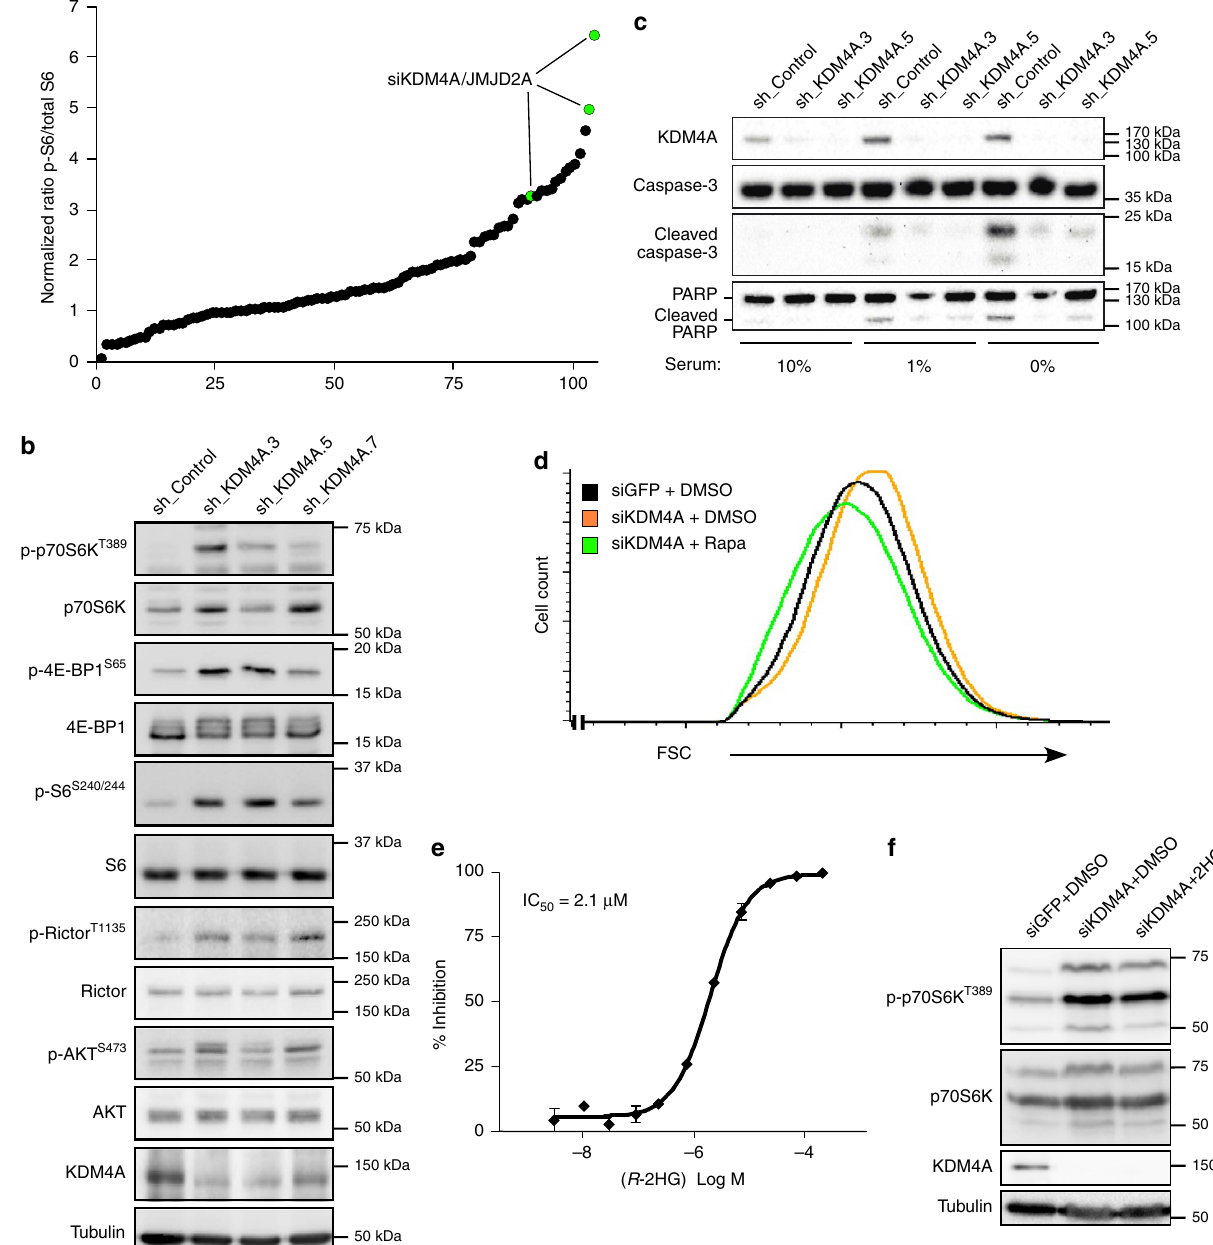
Figure 2 | Targeted-siRNA screen reveals KDM4A as an a -KG-dependent enzyme modulating mTOR activity. ( a ) siRNA screen of a KG-dependent enzymes for the involvement in mTOR signalling in HeLa cells. The experiments were performed in triplicate and the results of all experiments were plotted. The levels of phosphorylated S6 on serines 240/244 were normalized to total S6 protein. ( b ) KDM4A knockdown increases mTORC1/2 signalling. Depletion of KDM4A by lentiviral infection in HeLa cells using three different shRNAs. Whole-cell lysates were blotted for mTORC1/2 activation. ( c ) Depletion of KDM4A protects against apoptosis induced by serum deprivation. HeLa cells expressing a control shRNA or shRNAs targeting KDM4A were grown in media containing the indicated concentrations of serum for 24h. Cell lysates were then analysed by western blotting. ( d ) KDM4A depletion increases cell size in an mTORC1-dependent manner. MEFs p53 (cid:2) / (cid:2) were treated with siKDM4A and, where indicated, with DMSO or 25nM rapamycin, for 16h before FSC measurements by FACS. A total 200,000 cells were counted for each condition. ( e ) Dose-dependent inhibition of KDM4A by R -2HG in in vitro demethylation assay (graph represents two independent experiments). ( f ) 2HG does not further stimulate mTORC1 in KDM4A-depleted HeLa cells. HeLa cells transfected with siGFP or siKDM4A were serum starved for 16h before stimulation with 2mM octyl-2HG for 4h.